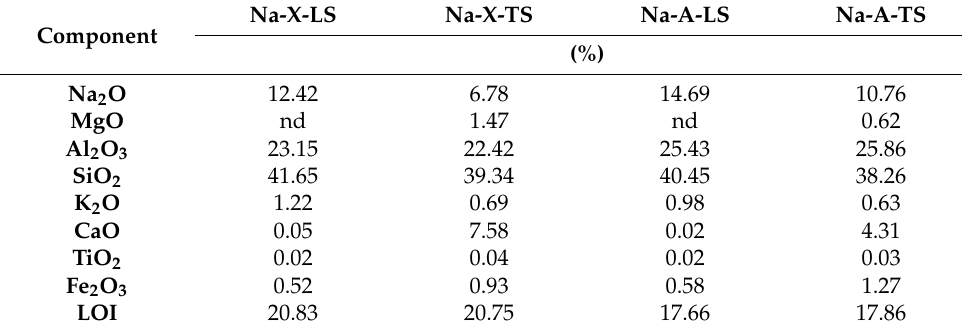
Table 3. Synthesis conditions of studied